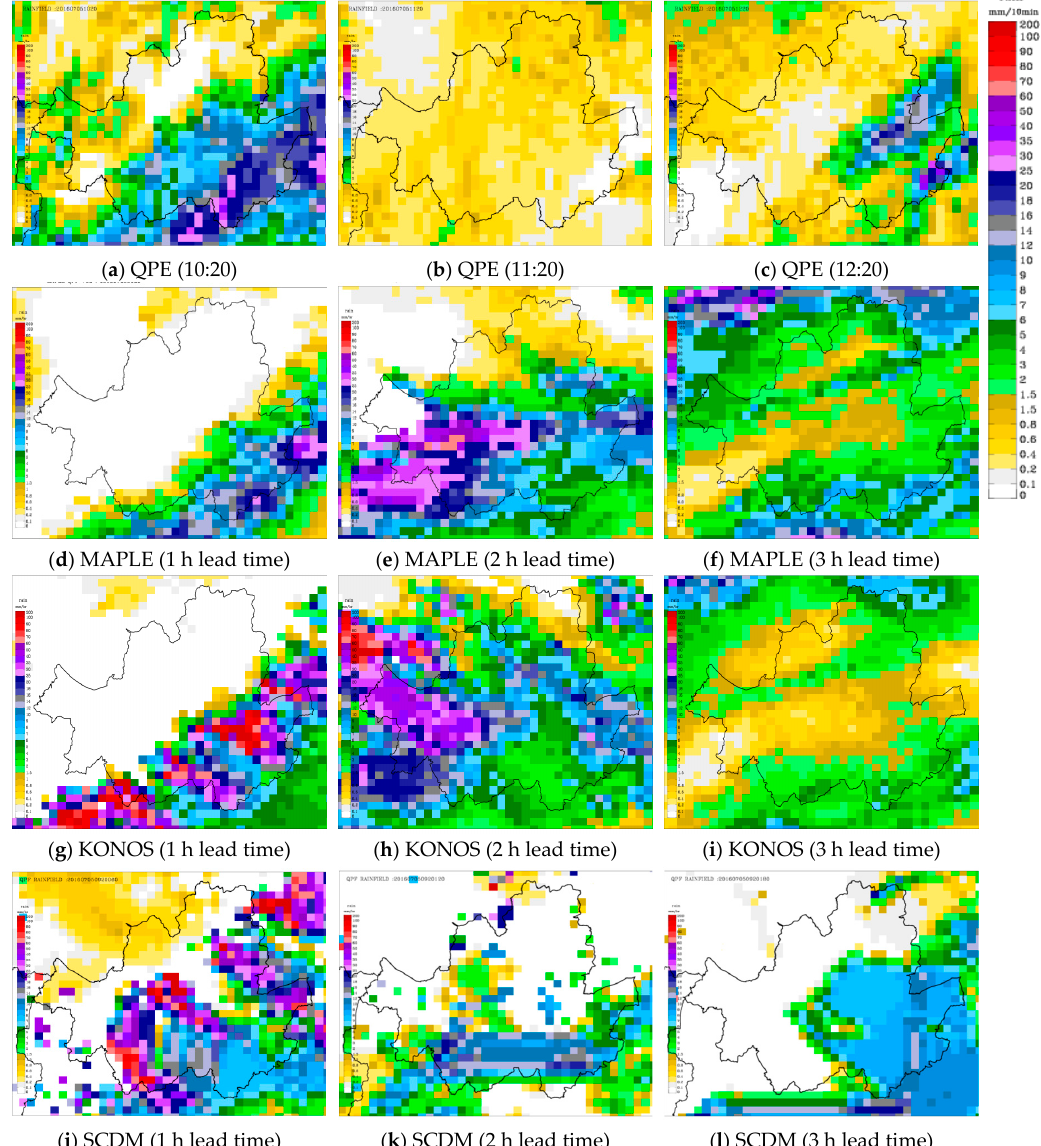
Figure 4. Comparison between actual quantitative precipitation estimates (QPE, a – c ) and QPF forecasts by the radar-based McGill Algorithm for Prediction Nowcasting by Lagrangian Extrapolation (MAPLE) ( d – f ), KOrea NOwcasting System (KONOS) ( g – i ), and Spatial-scale Decomposition method (SCDM) ( j – l ) models in the Seoul area with lead times of 1–3 h starting from 09:20, 5 July